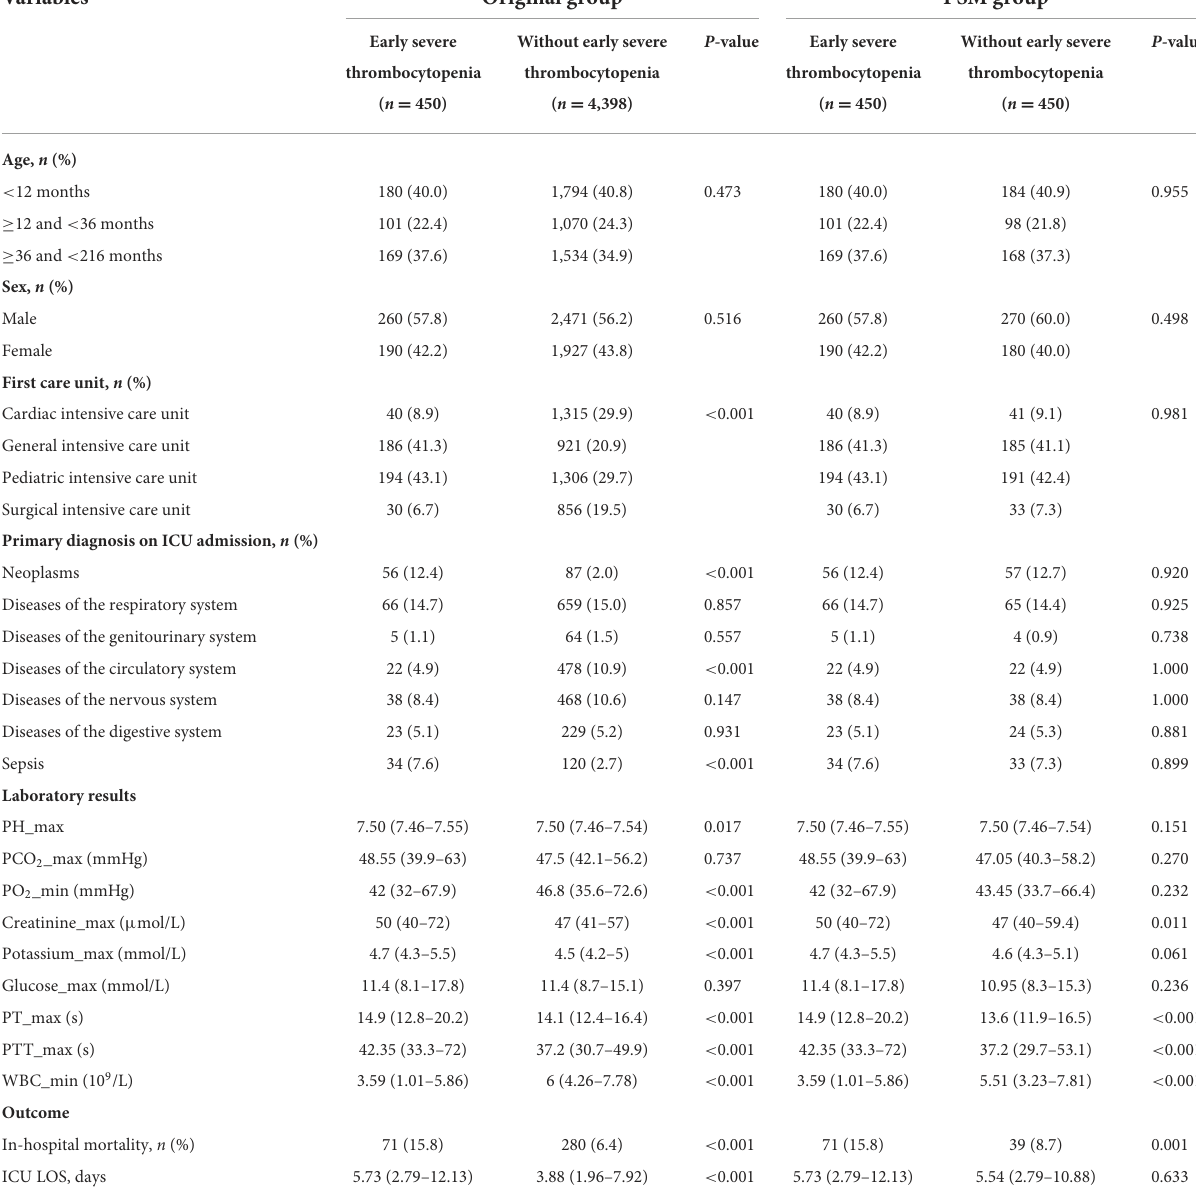
TABLE 1 Patient characteristics in the original cohort and the PSM